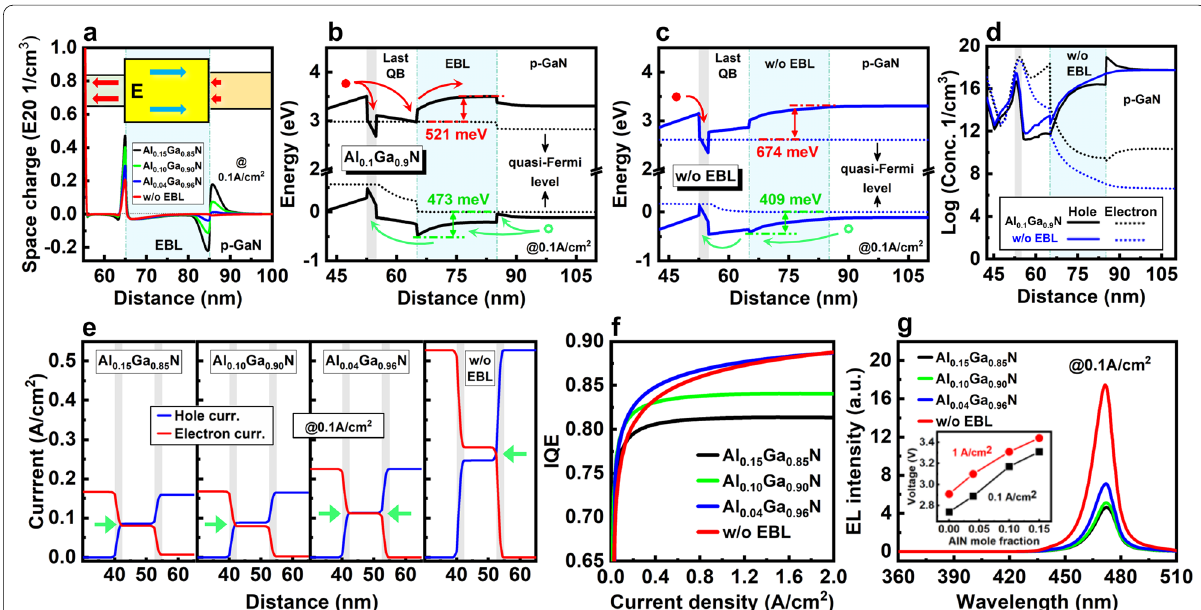
Fig. 8 a Space charge density distribution of 2QWs LED with different EBL. The inset shows the direction of polarization field. Energy band diagrams of 2QWs LED b with Al 0.1 Ga 0.9 N EBL and c without EBL. d Carrier concentration distribution, e carrier current density, f IQE and g EL spectra of 2QWs LED with different EBL. The inset of g shows the working voltages at 0.1 and 1 A/cm 2 with different EBLs